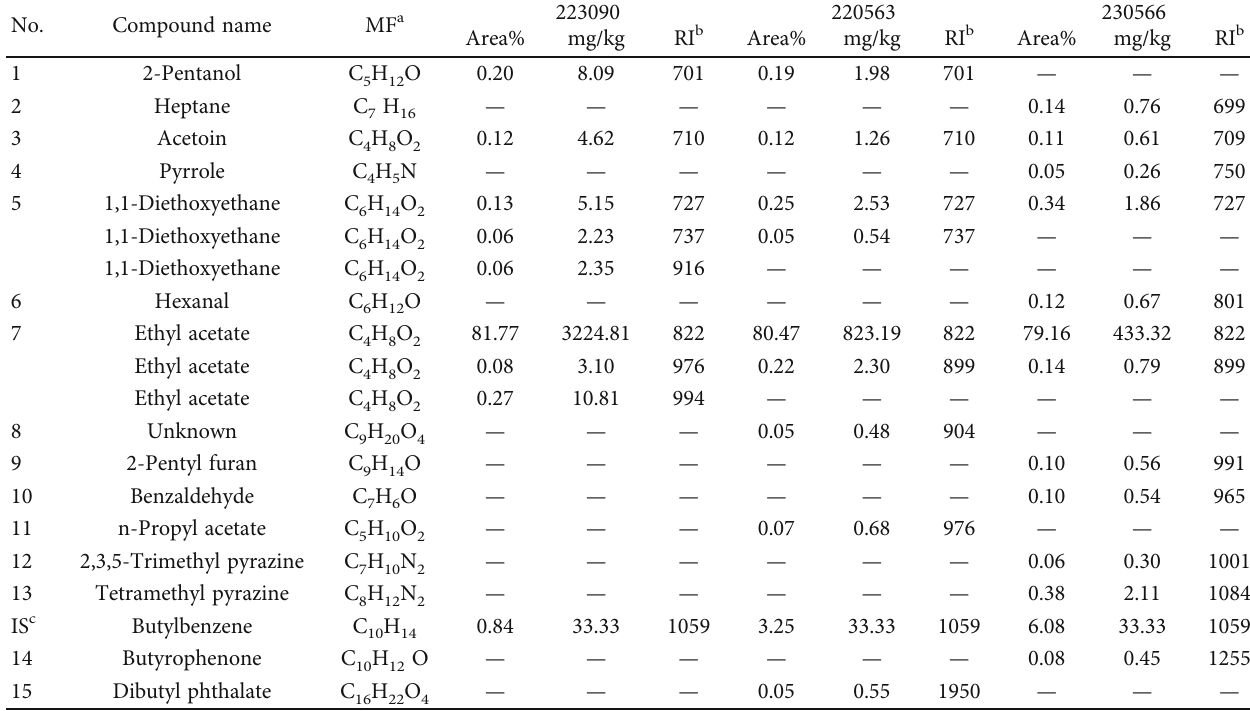
Table 3: Volatile fl avor compounds identi fi ed in anchote tuber.